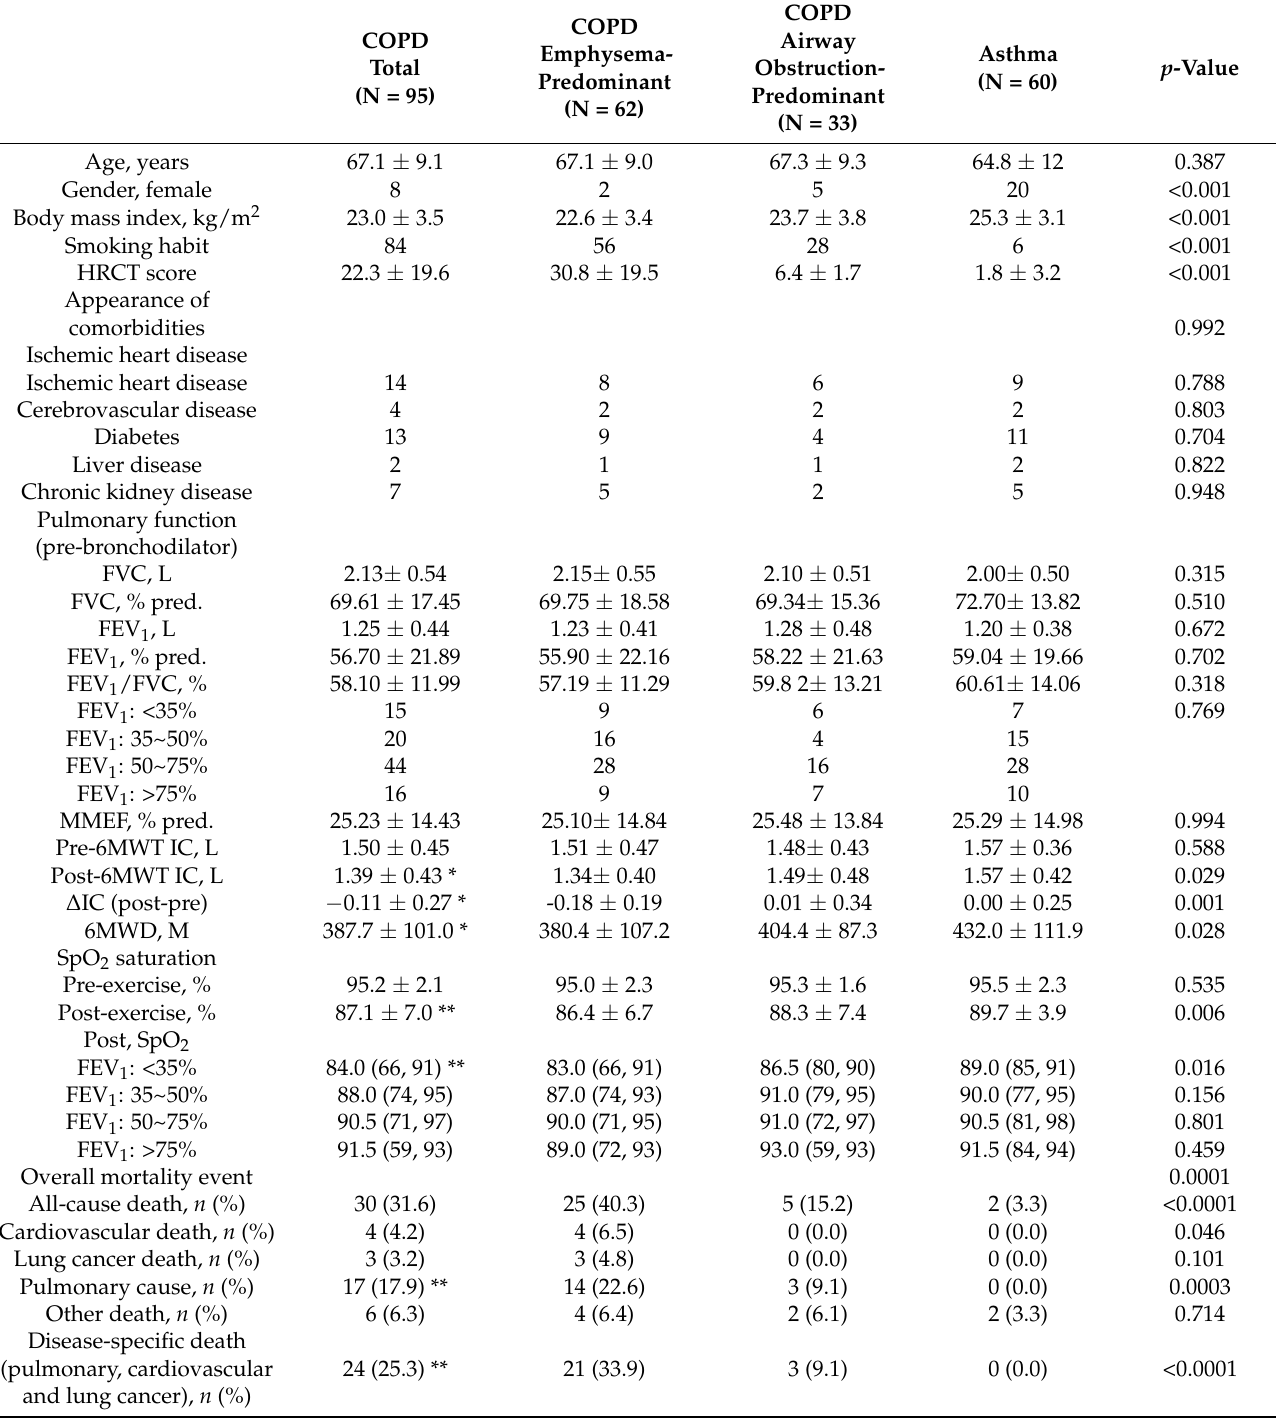
Table 1. Baseline characteristics of asthma and COPD with predominant emphysema or predominant airway